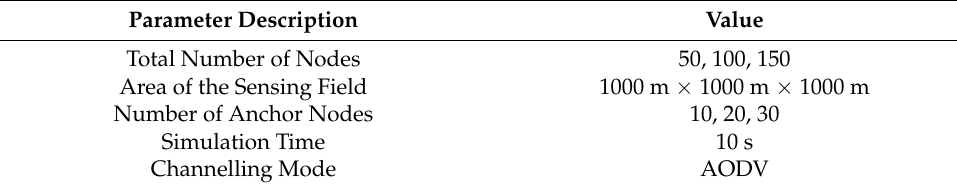
Table 1. Simulation settings.